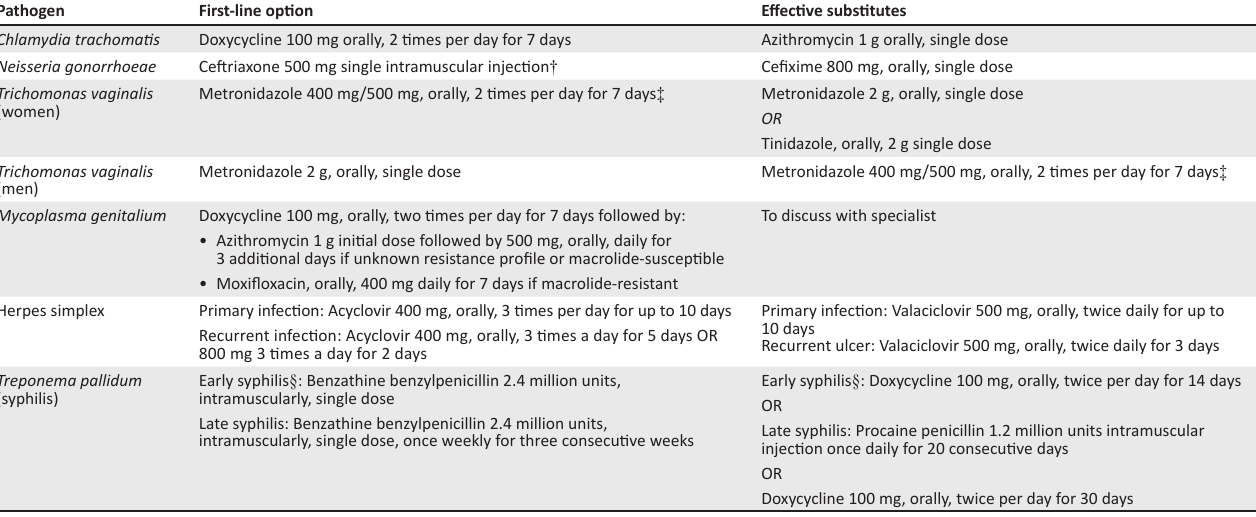
TABLE 6: Recommended antimicrobial drugs for targeted treatment of uncomplicated sexually transmitted infections.